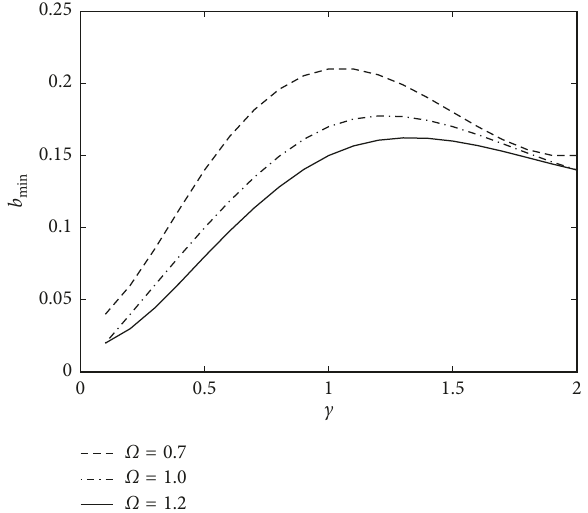
Figure 6: The curves of the critical value of b ( b different values of